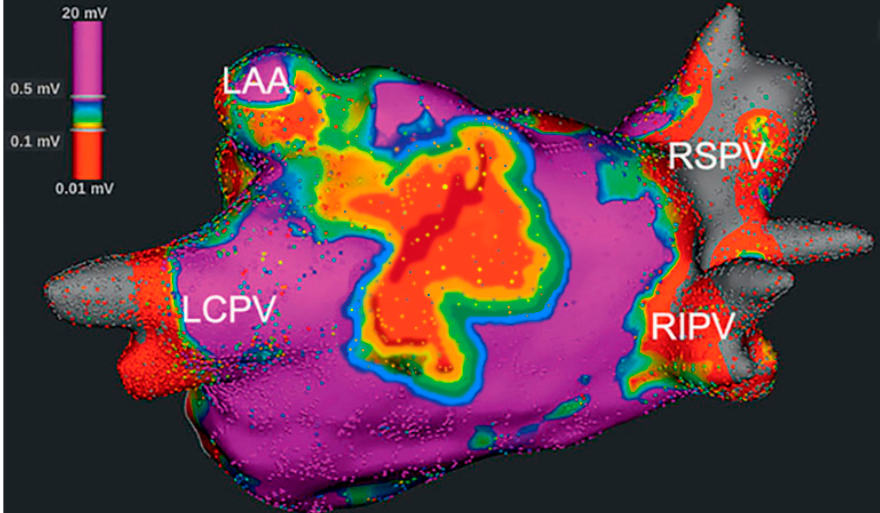
Figure 3. Low voltage zones in the LA are depicted during high-density bipolar voltage mapping. Bipolar voltage areas ≤ 0.1 mV are red, and those with voltage > 0.5 mV are purple, with interpolation of color for all the intermediate amplitudes.